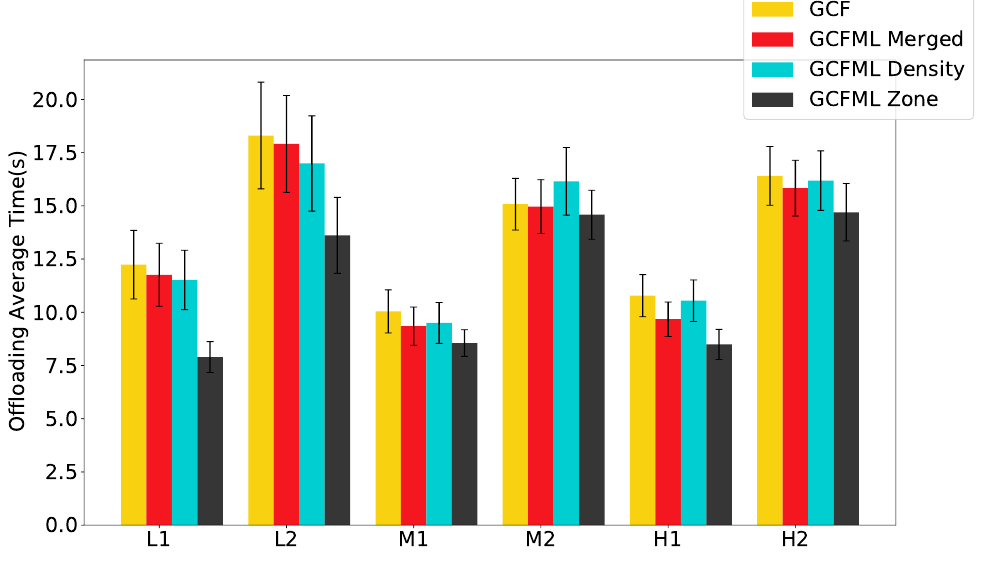
Figure 12. Time offloading of the approaches.